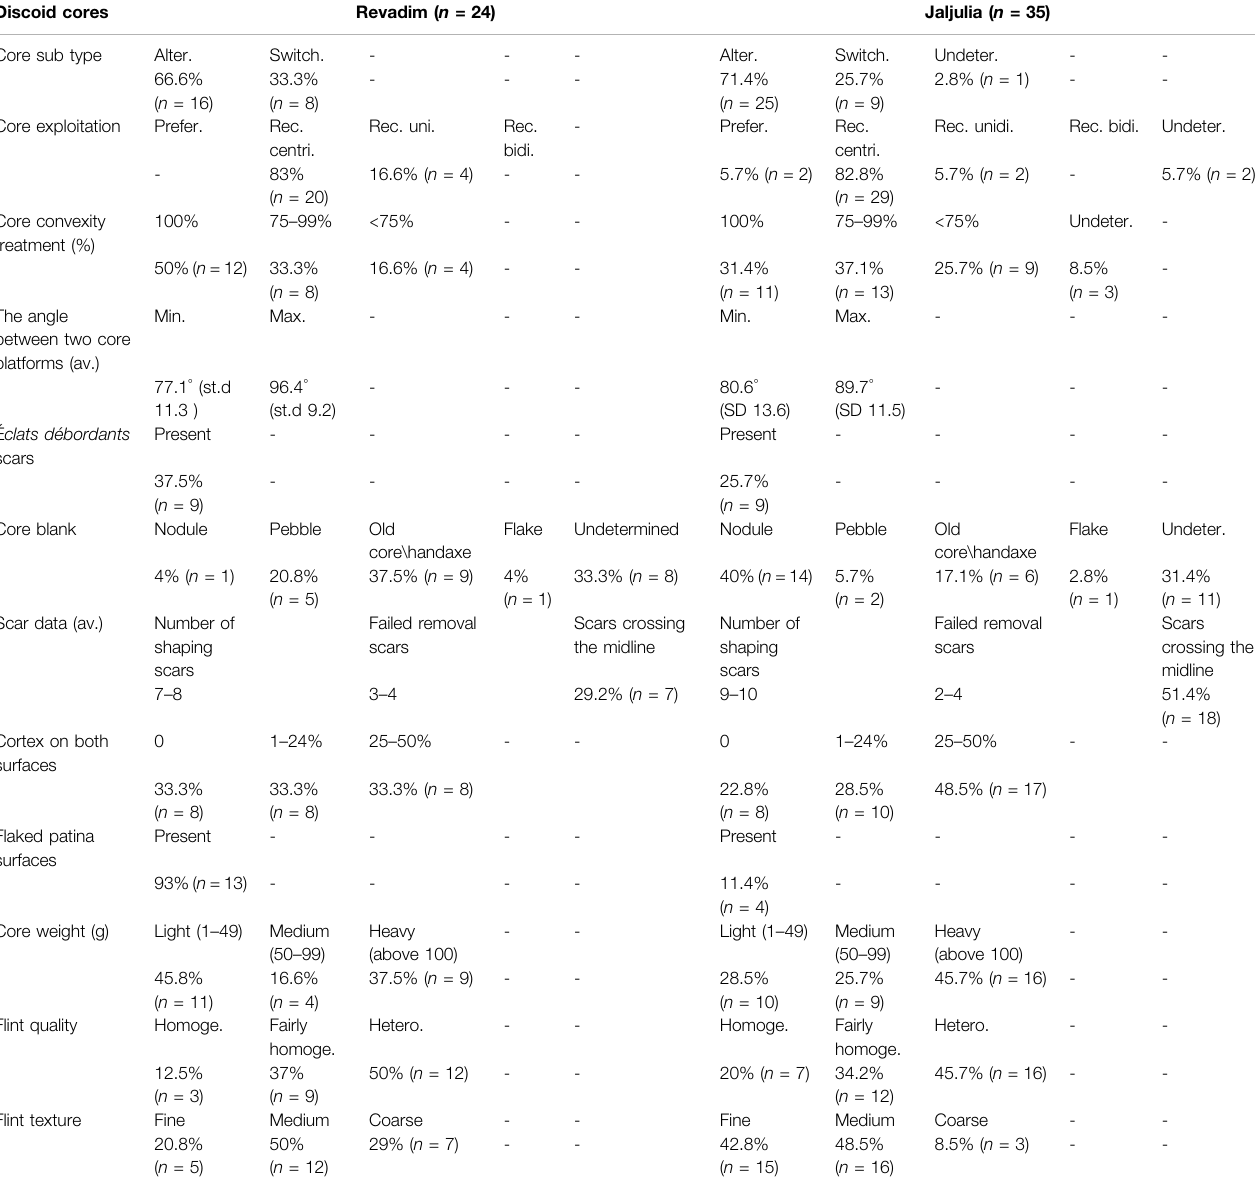
TABLE2| Majorattributesofdiscoidcoresfrombothsites.Alter.(Alternate);Switch.(Switchablehierarchy);Undeter.(Undetermined);Prefer.(Preferential);Rec.(Recurrent); centri. (centripetal); uni. (unidirectional); bidi. (bidirectional) Homoge. (Homogeneous); Hetero. (Heterogeneous). Discoid